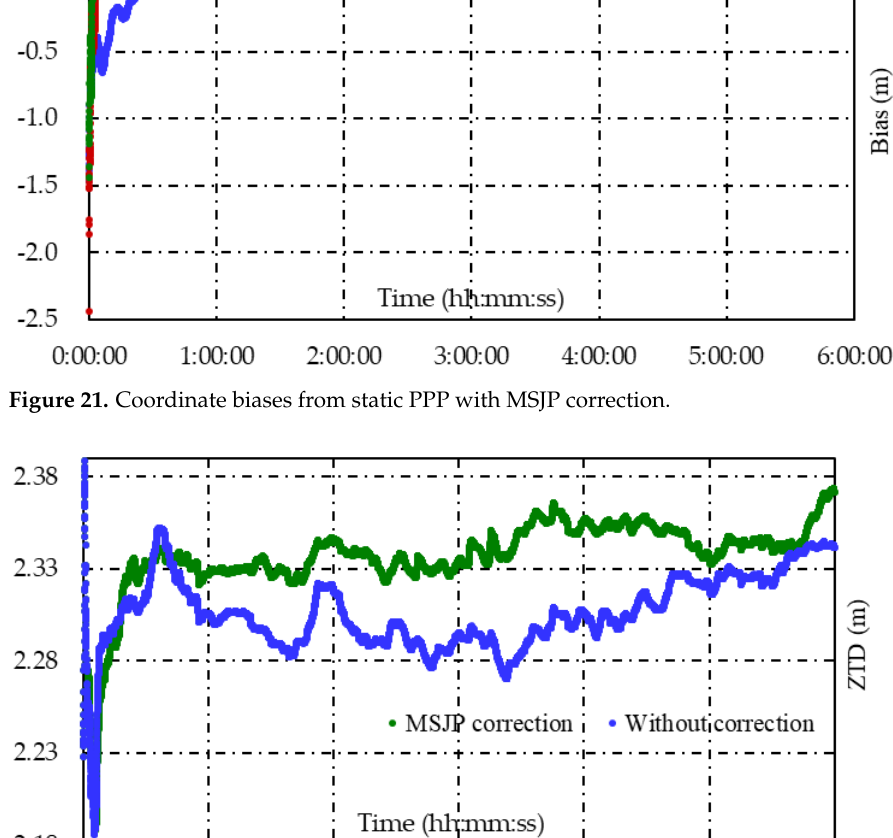
Figure 22. ZTDs from static PPP with and without MSJP corrections.